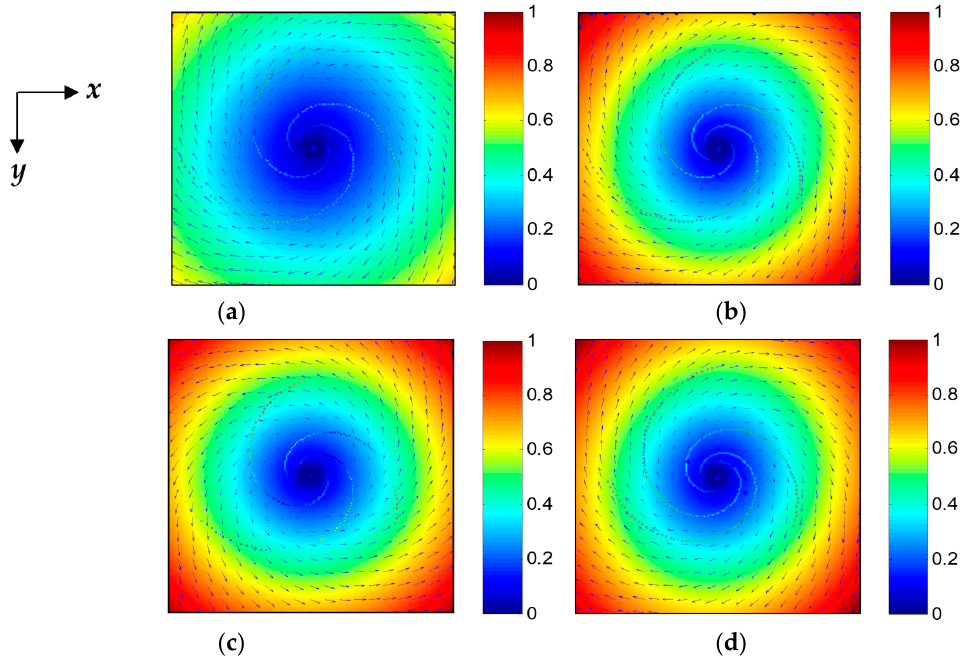
Figure 2. Simulated current fields of vortex based on the Burgers-Rott model. ( a ) α = 0.0204, Γ = 10 π , the maximum velocity of the vortex current field V max = 0.68 m/s, and the rotation direction of the vortex current field is clockwise. ( b ) α = 0.0272, Γ 0 / υ = 10 π , V max = 1 m/s, and the rotation direction of the vortex current field is clockwise. ( c ) α = − 0.0272, Γ 0 / υ = 10 π , V max = 1 m/s, and the current field is